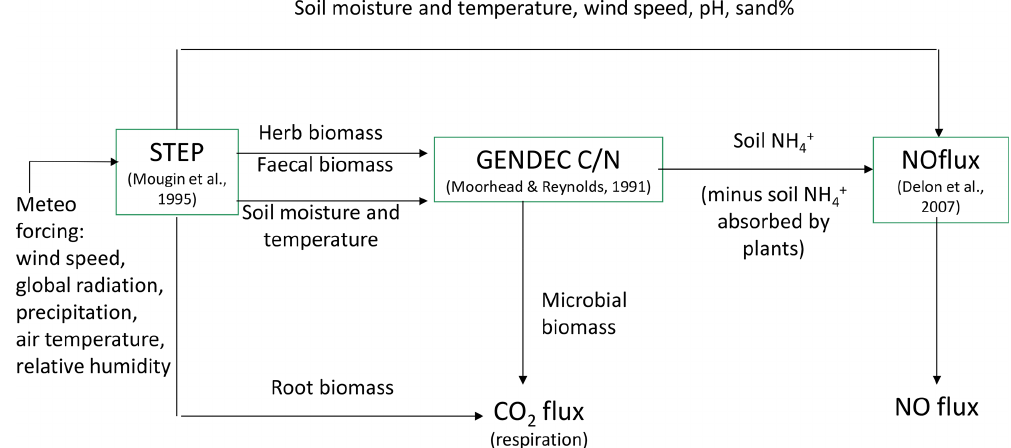
Figure 1. Schematic representation of NO and CO 2 flux modelling in STEP–GENDEC–NOflux (adapted from Delon et al., 2015).